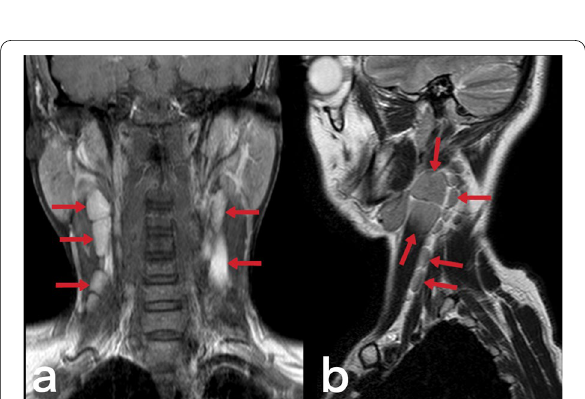
Fig. 9 Contrast-enhanced T1 weighted coronal ( a ) and sagittal T2 weighted ( b ) MR images of a 39-year-old female demonstrate multiple lymphadenopathies in the bilateral cervical chains. The patient was diagnosed with tuberculous lymphadenitis